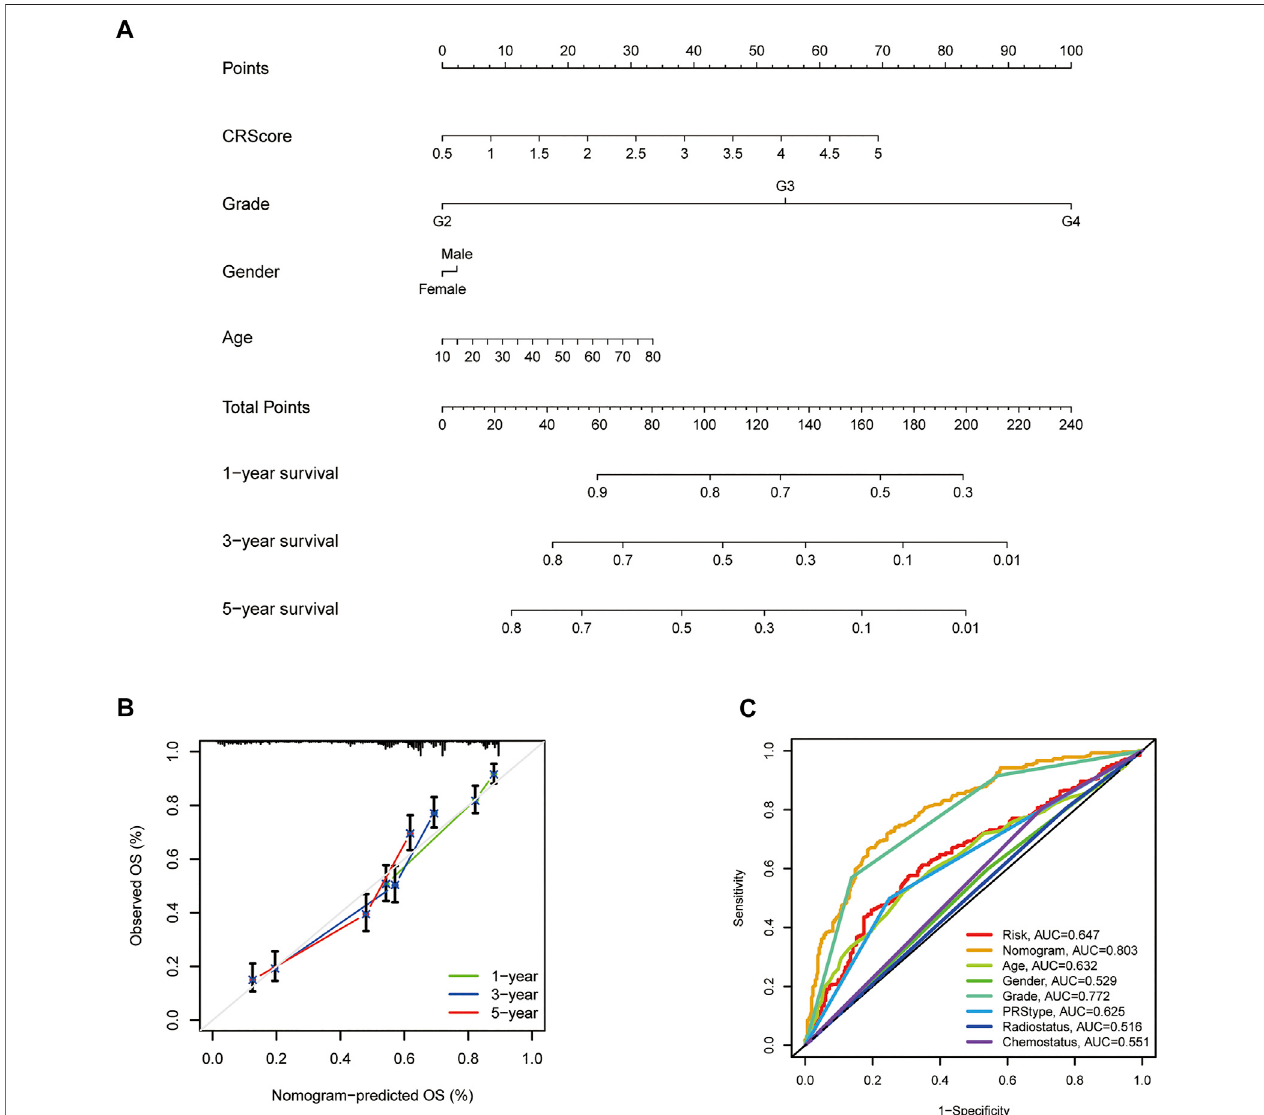
FIGURE8| Establishmentandapplicationofthescoringmodelintheexternalvalidationcohort. (A) NomogramforthepredictionofOSat1,3,and5 years. (B) The calibration curves for external validation of the nomogram. (C) The clinical ROC curves of the CXCR-related nomogram at 3-year OS.